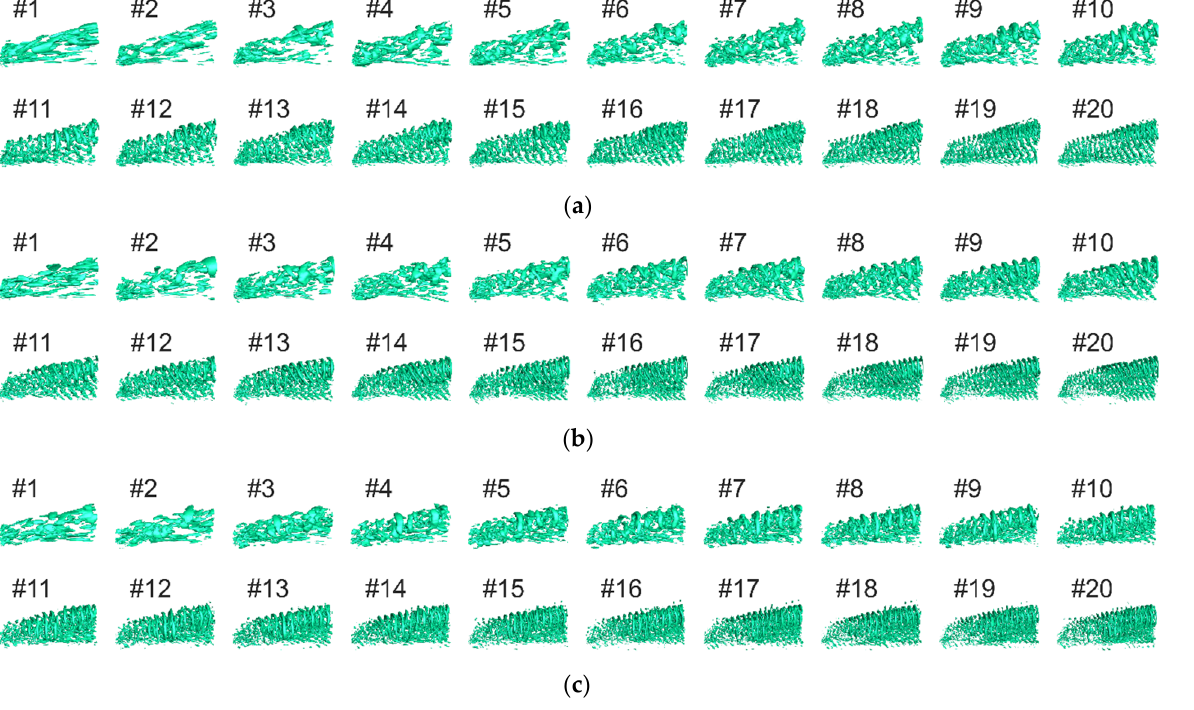
Figure 9. Vortical structures of the first 20 modes behind the MVG with ( a ) Ma 1.5, ( b ) Ma 2.0, ( c ) Ma